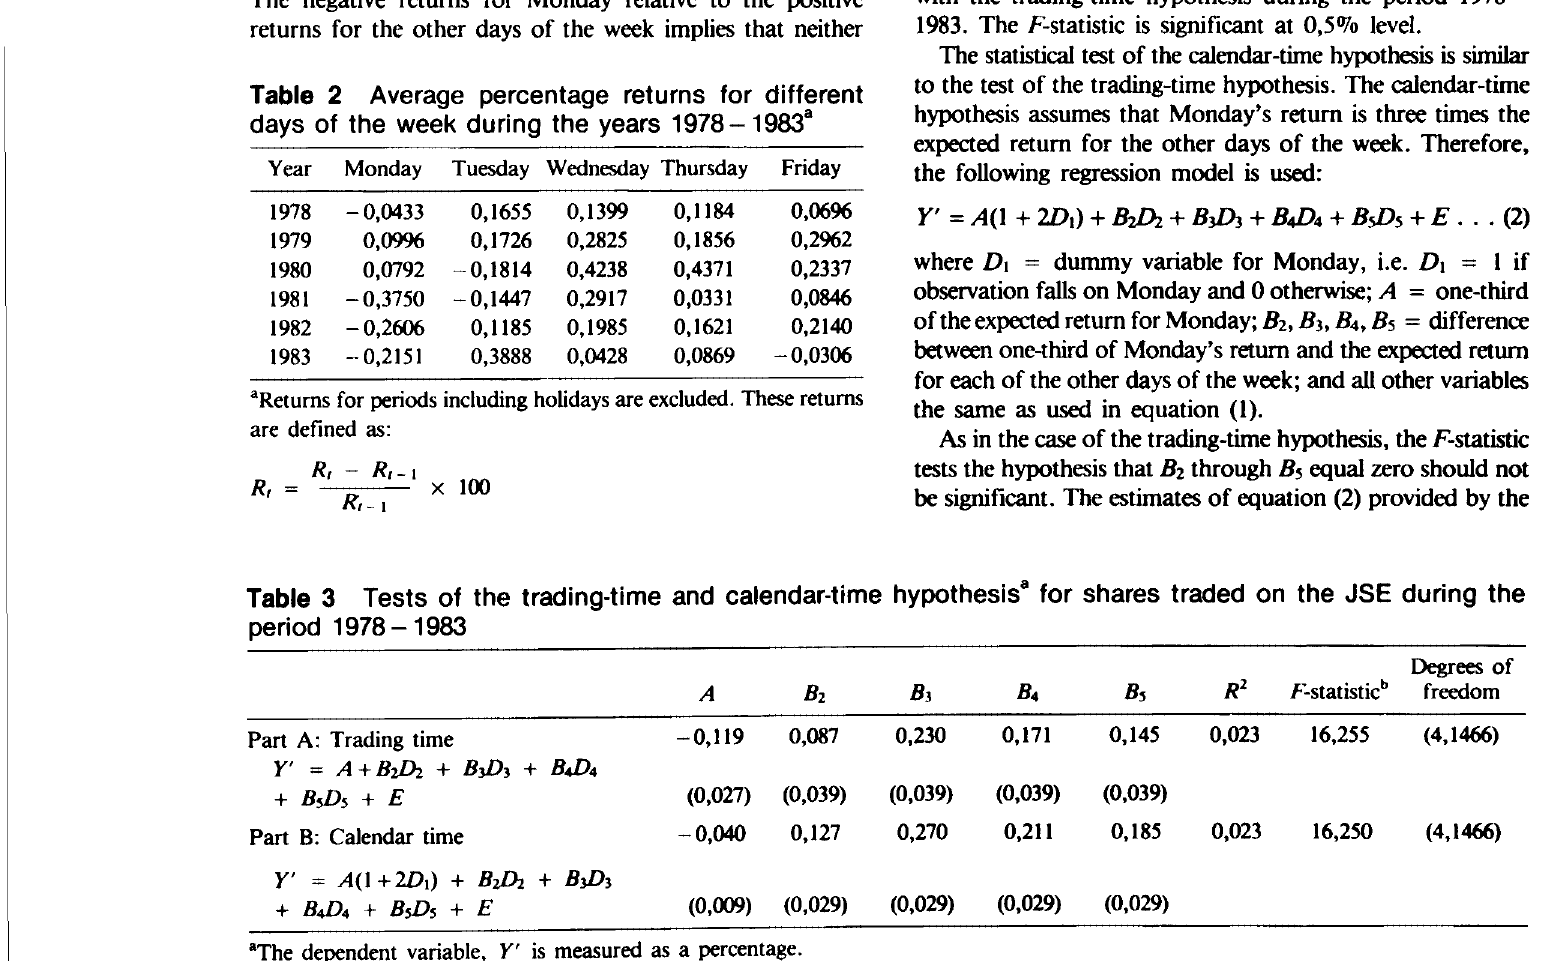
Average percentage returns for different days of the week during the years 1978-1983